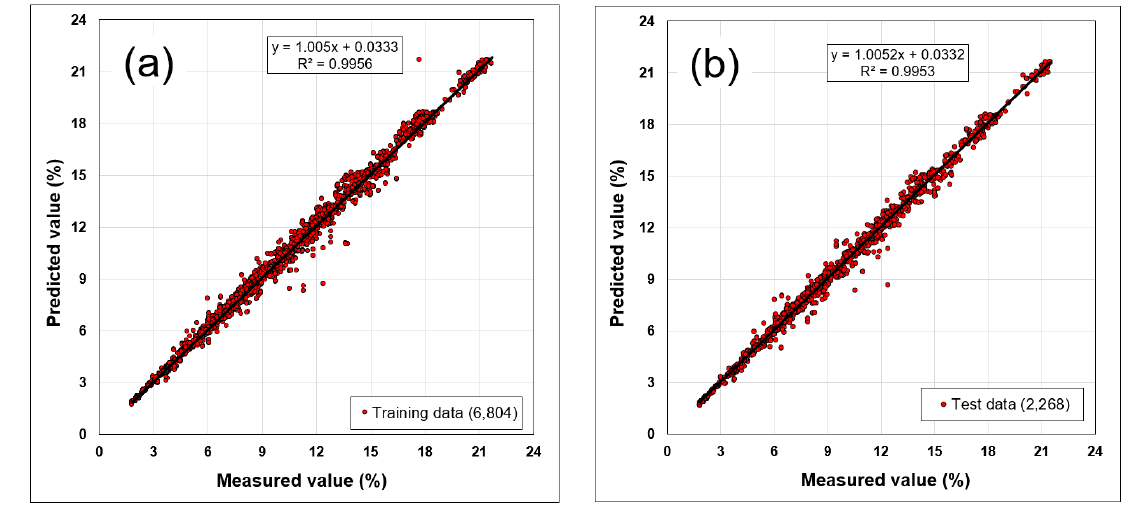
Figure 9. Results of correlation analysis between measured and predicted crusher utilization (%) using DNN model with four hidden layers and 40 hidden layer nodes: ( a ) training data and ( b ) test data.